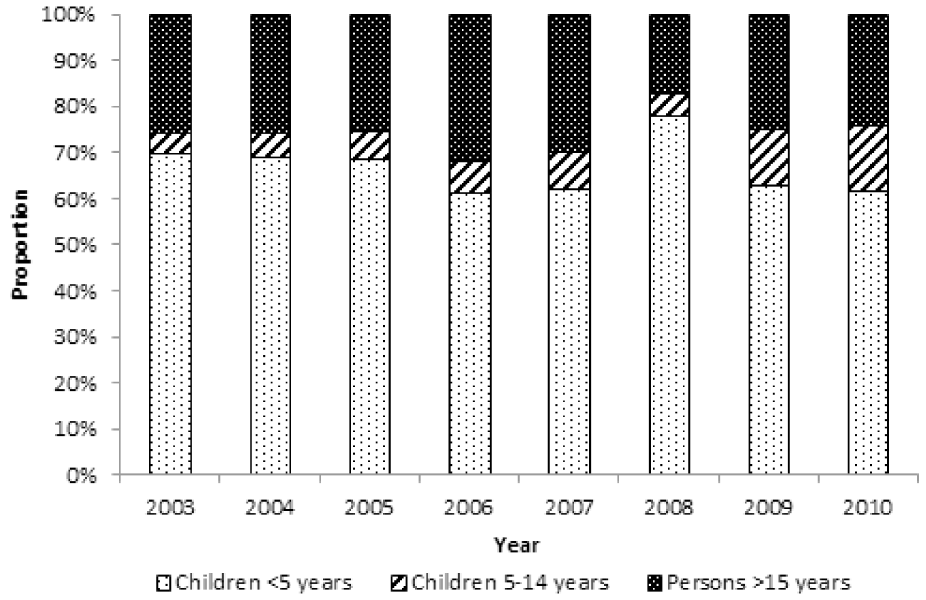
Figure 2. Trend in the proportion of malaria mortality by age group.